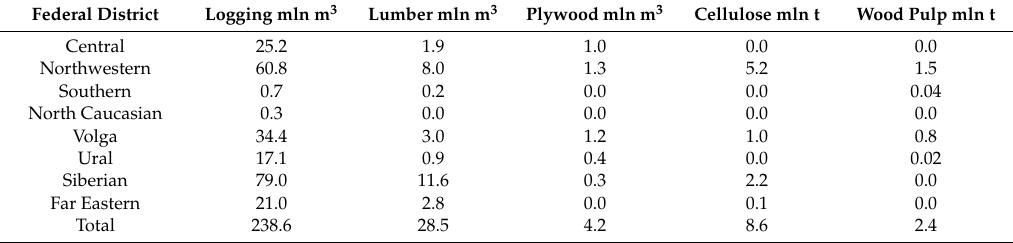
Table 1. Production of the timber industry complex (2018) by federal districts, mln m 3 / mln